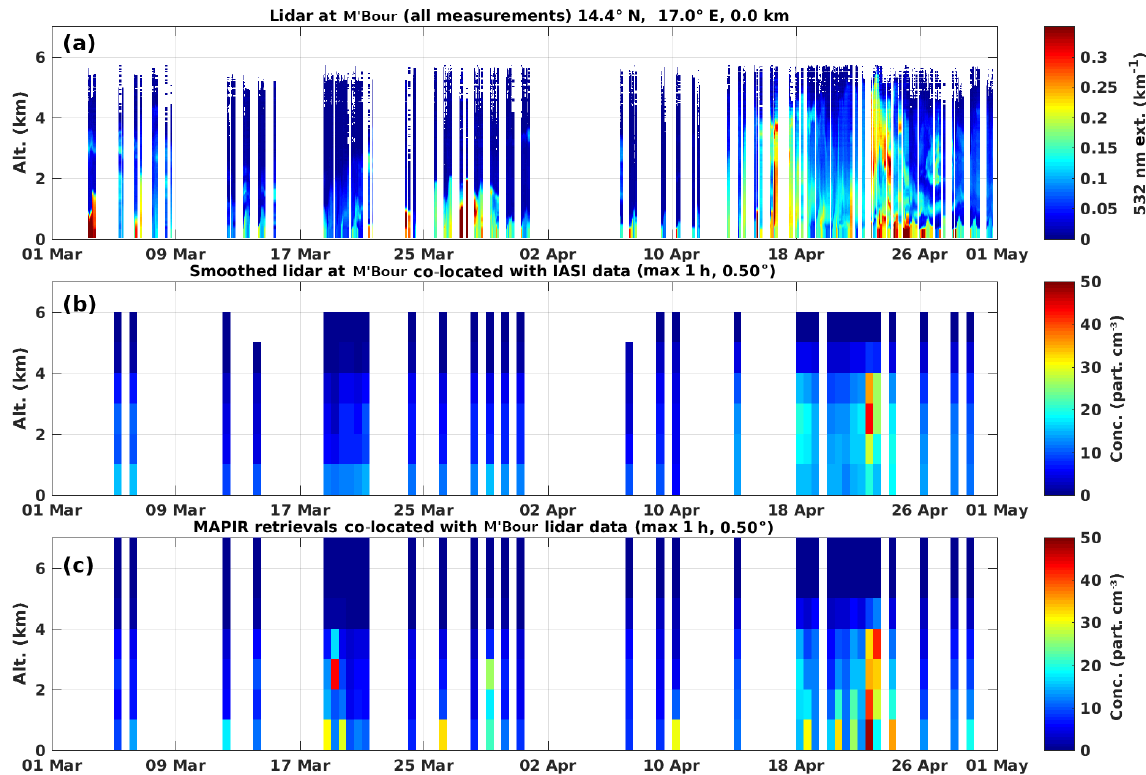
Figure 9. Same as Fig. 8 but for 1 March to 1 May